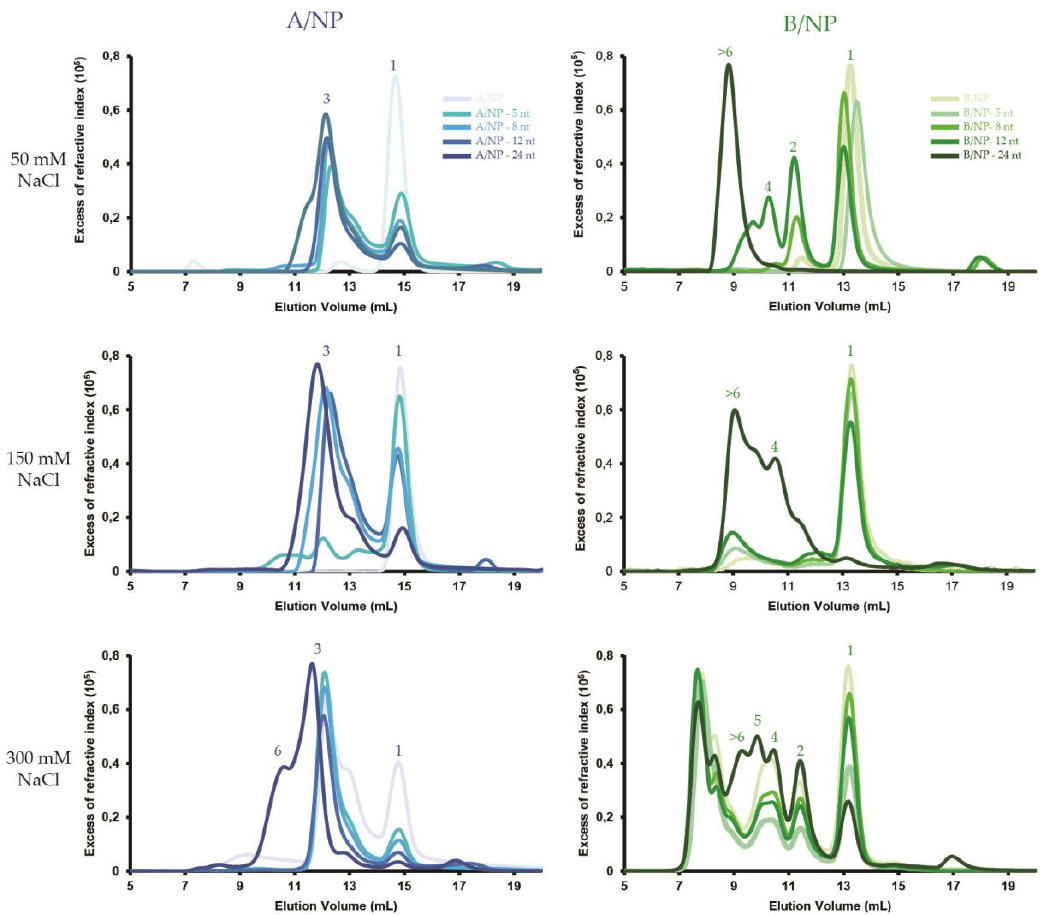
Figure 3. SEC-MALLS analysis of oligomeric states of the nucleoproteins of influenza A and B virus according to RNA length. SEC-MALLS analysis were performed on a Superdex 200 increase column equilibrated with 20 mM Tris-HCl pH 7.5 and different NaCl concentrations, from 50 to 300 mM. Protein is injected alone or in complex (ratio 1:1) with a short 5′ phosphate-polyUC-OH 3′ RNA from five to 24 nucleotides. Complexes are incubated 1 h at room temperature before injection. For each buffer condition, the relative proportion of oligomers eluted from the column gradually increased upon increasing RNA length. Peaks are labelled 1 for monomer, 2 for dimer, 3 for trimer, 4 for tetramer, 5 for pentamer, and >6 for larger than hexamer.